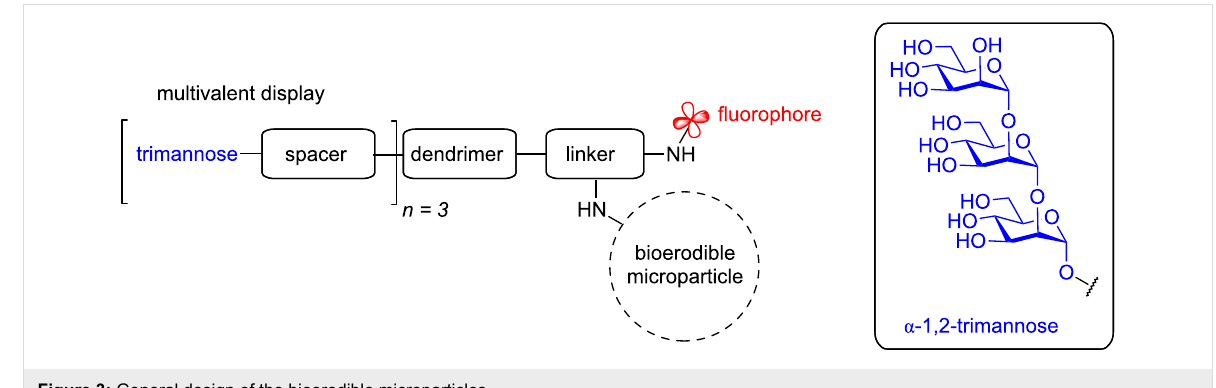
Figure 3: General design of the bioerodible